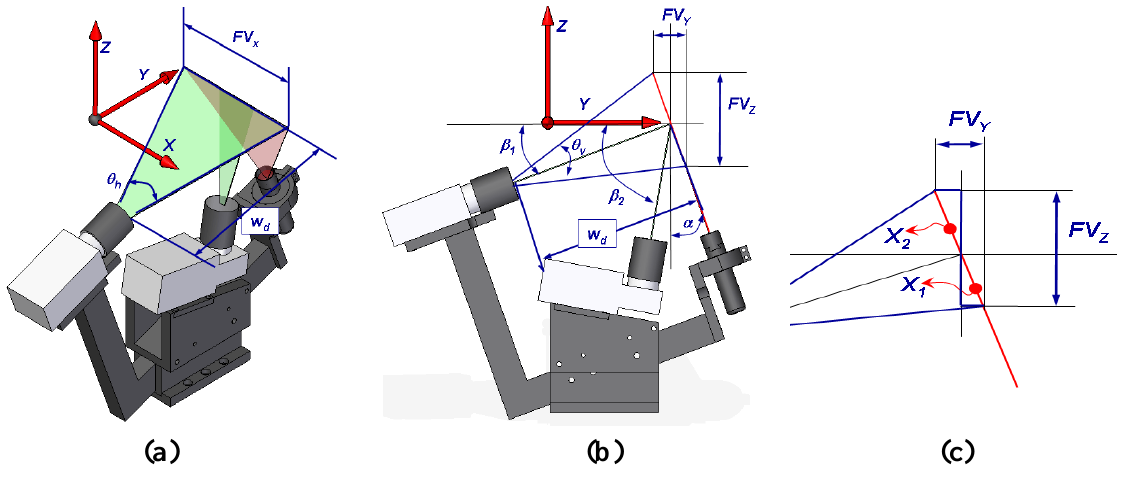
Figure 1. Influence of the geometrical parameters in the field of view of the LTS. (a) Field of view in X axis. (b) Field of view in Y and Z axis (c) Two components detailed decomposition of the field of view in Y and Z directions.